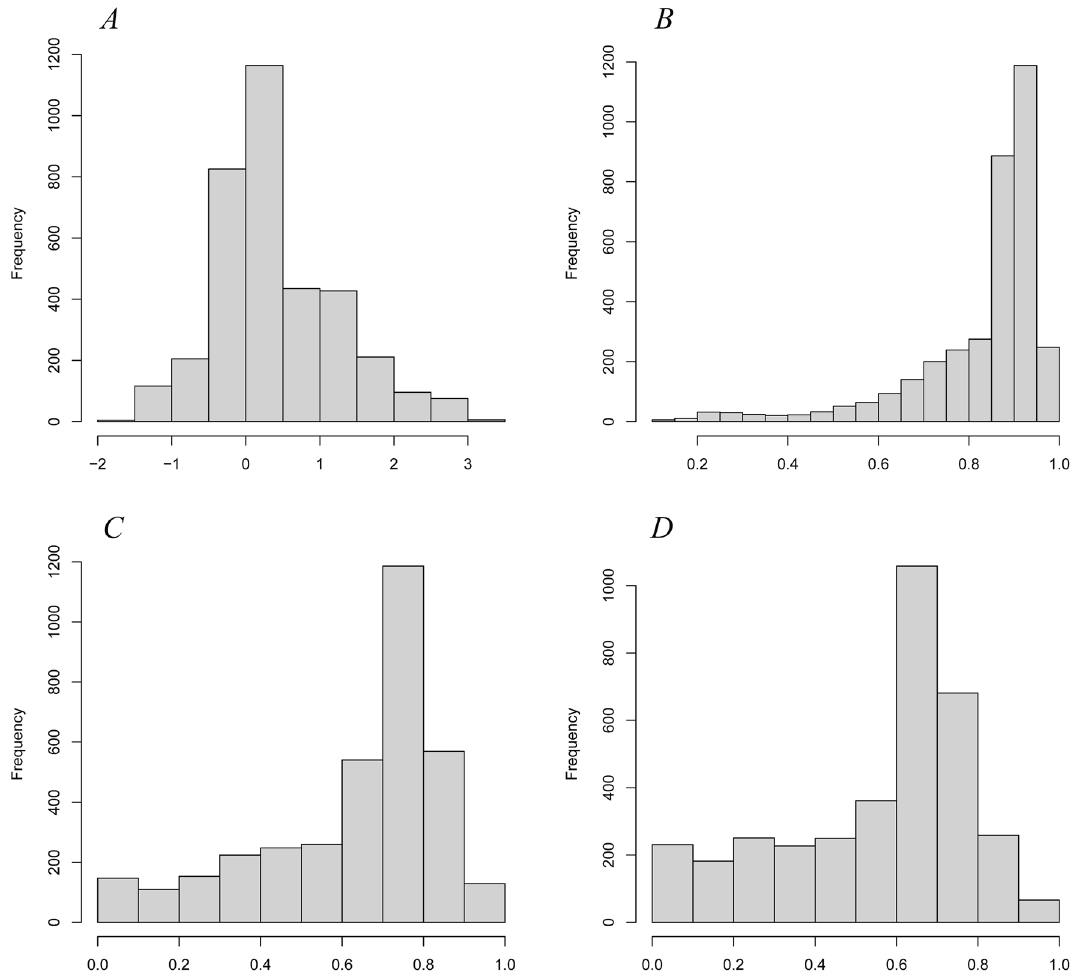
Figure 1. Linear predictor ( A ) and predicted probability ( B – D ). ( B – D) Shows 1-year, 3-year, and 5-year predicted probability,